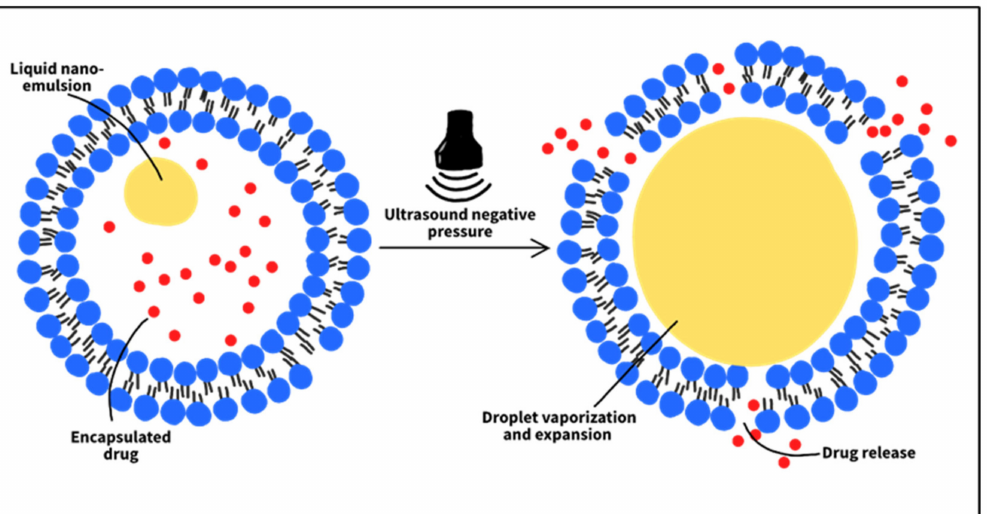
Figure 8. Liposomes containing nano-emulsions (emulsion liposomes). When exposed to ultra- sound’s negative pressure, the nanodroplet vaporizes and expands inside the aqueous core, disturbing the liposomal membrane and leading to drug